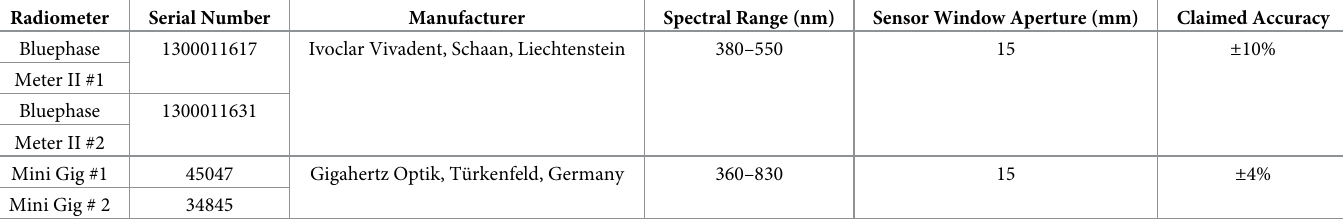
Fig 2. The two examples of the Bluephase Meter II and the Mini Gig radiometer used in the study. https://doi.org/10.1371/journal.pone.0267359.g002 and was noticeably different from the other LCUs. Fig 5 illustrates the power values from the 24 LCUs when measured with the ‘GS’ and using the other 4 radiometers. Apart from the Pinkwave LCU when it was measured using both examples of the Bluephase Meter II, Fig 5 shows that all the measurement methods produced similar power values from the LCUs. How- ever, statistically, there were significant differences in the power values reported from the vari- ous radiometers when measuring each LCU (p < 0.05). Fig 6 compares the 12 brands of LCUs as a percentage of the maximum power (929 mW) that was measured using the ‘GS’ system. This maximum value was measured from the SmartLite Pro unit, but the Valo Grand and Pinkwave both delivered similar power values (918 and 905 mW, respectively). However, 5 LCUs (Dental Spark, Denjoy, Woodpecker LED.D, Woodpecker LED.B, and the SDI Radii Plus) delivered only 59%, 50%, 41%, 39% and 33% respectively of the power from the Smar- tLite Pro. Table 2. Information provided by the manufacturers about their